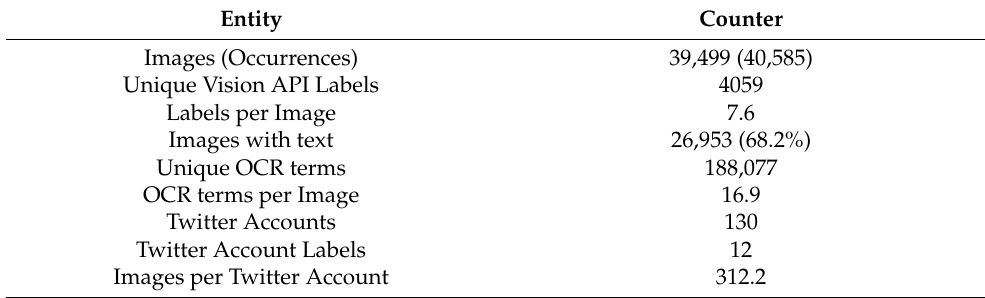
Table 2. Politics dataset